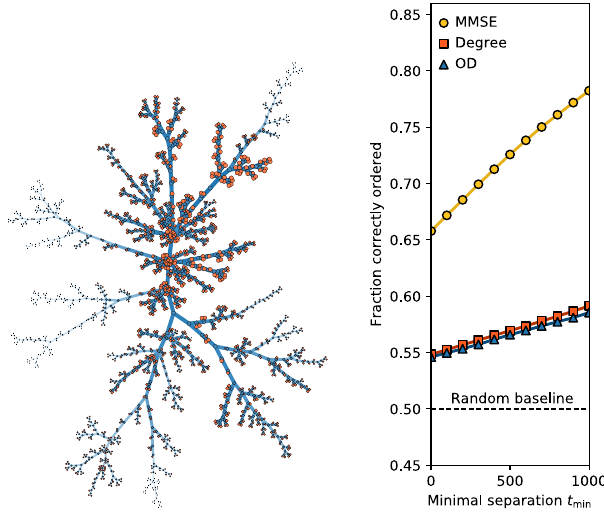
FIG. 8. Application to the phylogenetic tree of strains of the Ebola virus. (Left diagram) Leaves ( n ¼ 1238 , in orange) represent strains of Ebola sequenced during the 2013 – 2016 West African outbreak [65], while the remainder of the nodes represent inferred common ancestors ( n ¼ 959 , in blue), and edges are most likely mutations [66]. Edge thicknesses indicate age according to the ground truth. We find that this network is best ˆ b modeled with ¼ 1 and ˆ γ ¼ − 0 . 71 , associated with a KS statistic of D (cid:3) ¼ 0 . 17 and a significance level of P ð D > D (cid:3) Þ ¼ 0 . 53 under the random model, signaling a good fit (see Appen- dix A for details). The uncertainty score of the MMSE estimators is equal to U ð G Þ ¼ 0 . 001 [see Eq. (8)]. (Right diagram) Fraction of edge pairs correctly ordered by the estimators, when separated by at least t time steps according to the metadata. Ties are min broken at random for the degree and OD estimators. MMSE estimators are calculated with the n ¼ 25 000 Monte Carlo